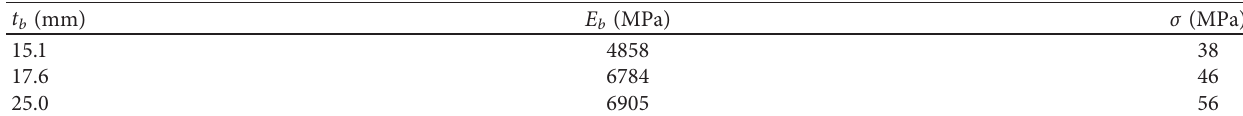
Table 2: Material properties of bamboo plywood.